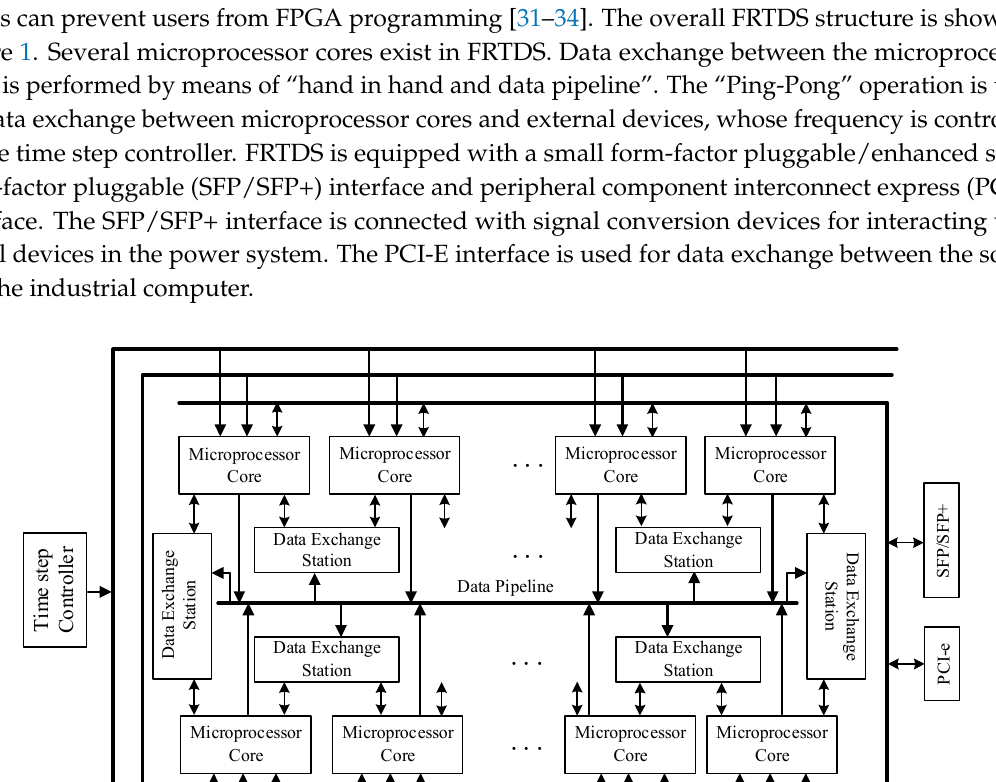
Figure 2. The structure of a microprocessor core.